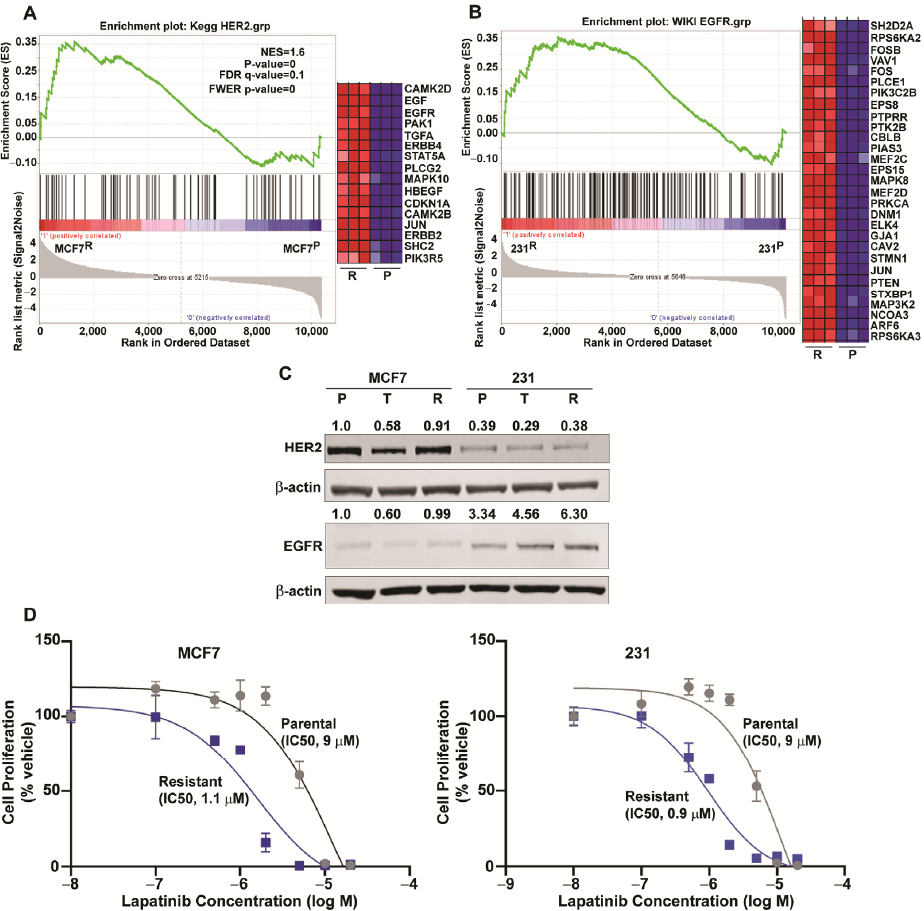
Figure 5. Alterations in growth factors and their pathway gene expressions in FOXM1 inhibitor sensitive and resistant breast cancer cells, and the enhanced sensitivity of resistant cells to lapatinib. ( A , B ) GSEA enrichment plots for HER2 and EGFR pathway genes showing elevated expression of these genes in resistant versus parental cells. A, MCF7 cells; B, 231 cells. ( C ) Western blot analysis of HER2 and EGFR protein levels in MCF7 and 231 parental (P), short-term (24 h), treated (T), and resistant (R) cells. Numbers above the blots show level corrected for the loading control β -actin. Level in MCF7 P cells is set at 1.0. Original blots see Figure S3. ( D ) Dose–response cell proliferation assays showing increased sensitivity of FOXM1 inhibitor resistant cells to lapatinib. MCF7 P and MCF7 R cells (left) and 231 P and 231 R cells (right) were treated with control vehicle or the indicated concentrations of lapatinib for 5 days. Values are mean ± SEM of triplicate assays.